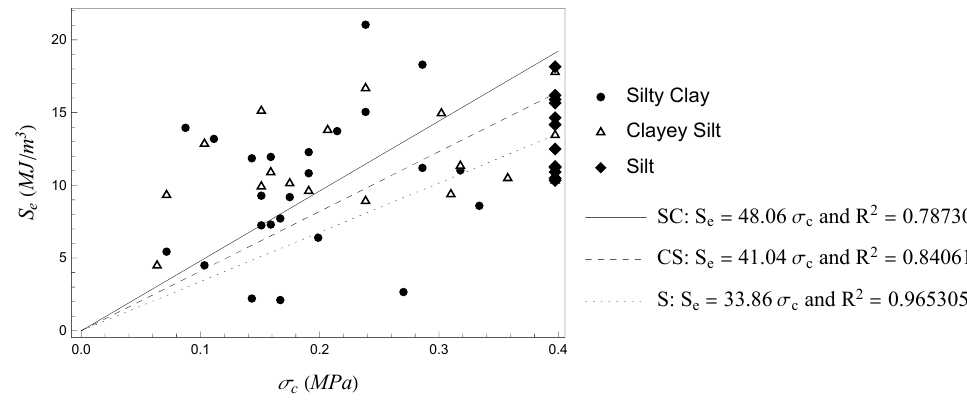
Figure 2. Relation S e vs. σ c